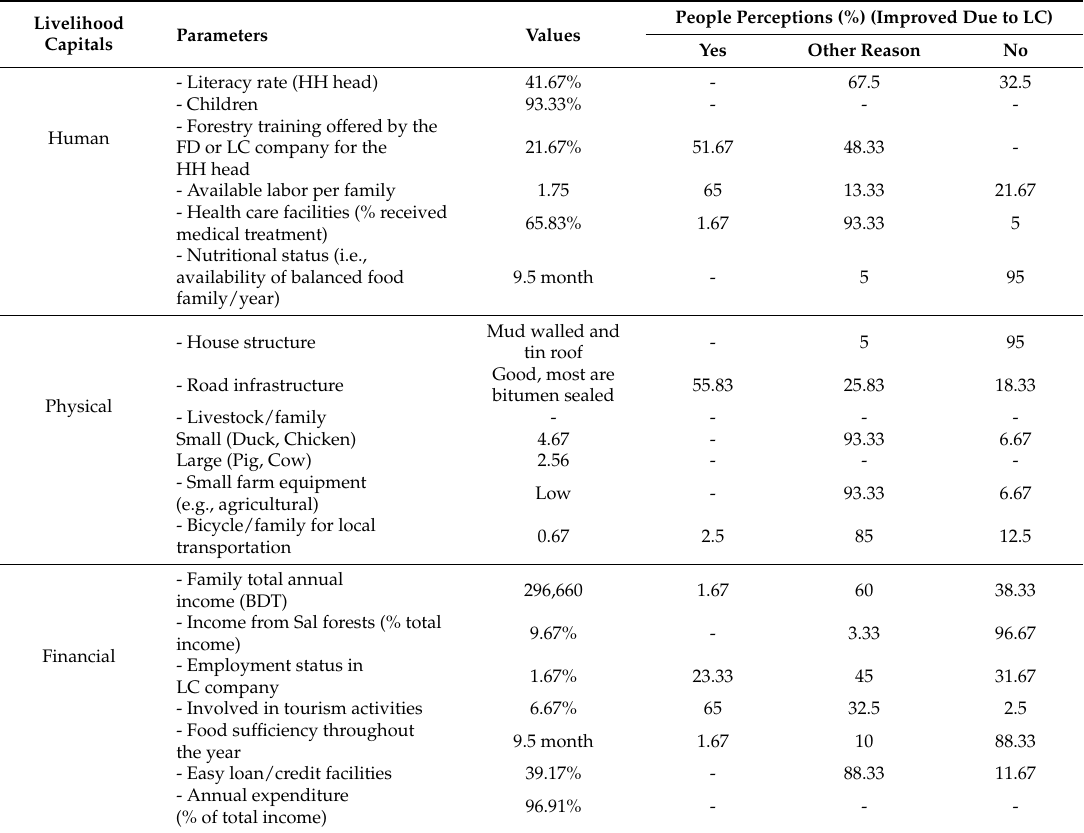
Table 6. Forestland concession and its impacts on the livelihood assets of the ethnic